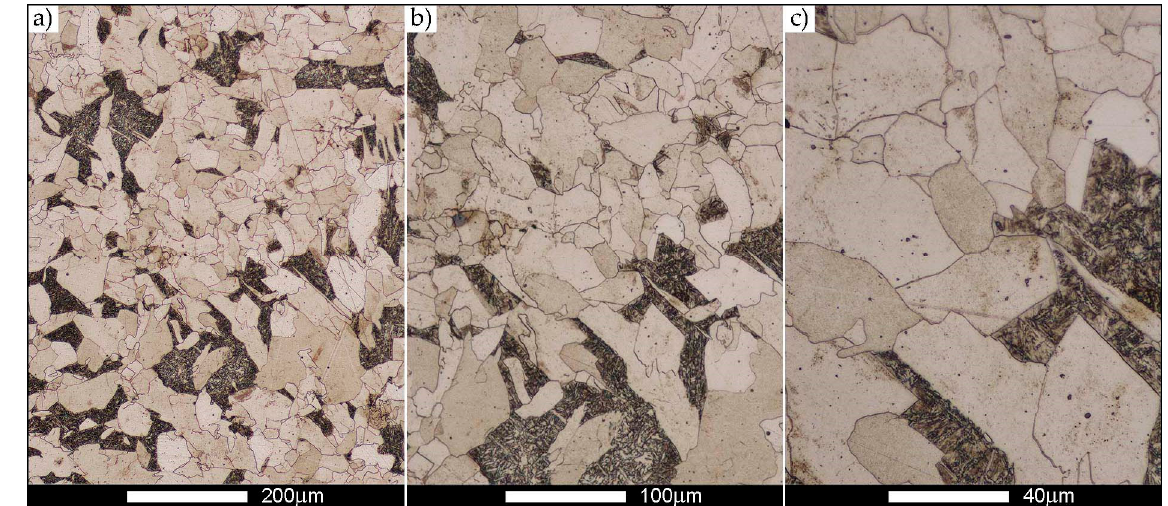
Figure 48. Welded joint microstructure of Hardox 450 steel with visible prior austenite grain boundaries, austenitised at 1200 ◦ C—WM3 zone shown in Figure 2. ( a ) 100 × ; ( b ) 200 × ; ( c ) 500 × .